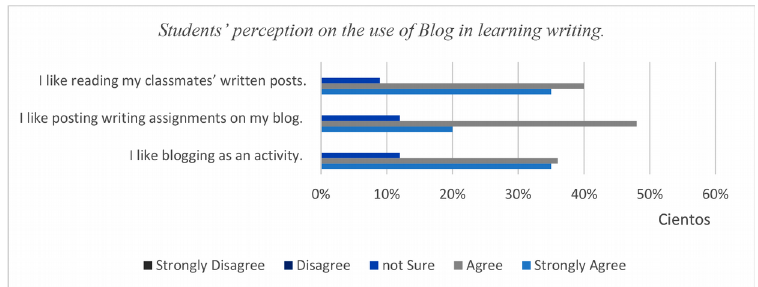
Figure 1. Students’ perception on the use of Blog in learning writing